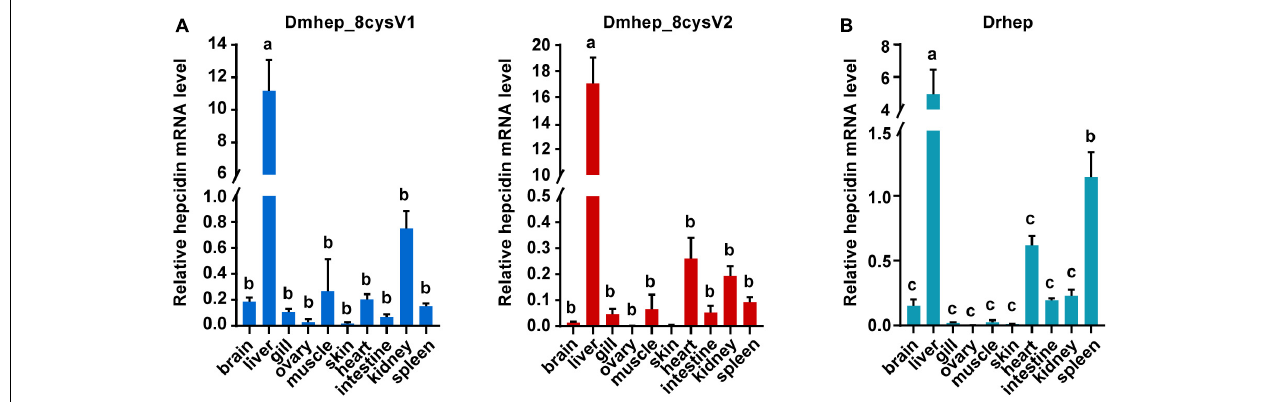
FIGURE 3 | The relative mRNA expression of hepcidin variants in different tissues of D. mawsoni (A) and D. rerio (B) . Error bars, mean ± SD, n = 3 (biological replicates). The same letters (a, b, and c) indicate no significant difference between different tissues, and different letters indicate statistical difference ( p < 0.05) between different tissues.